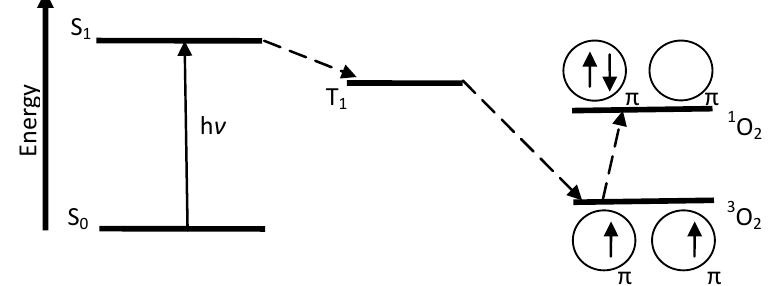
Figure 3. Modified Jablonski diagram showing Type II sensitization